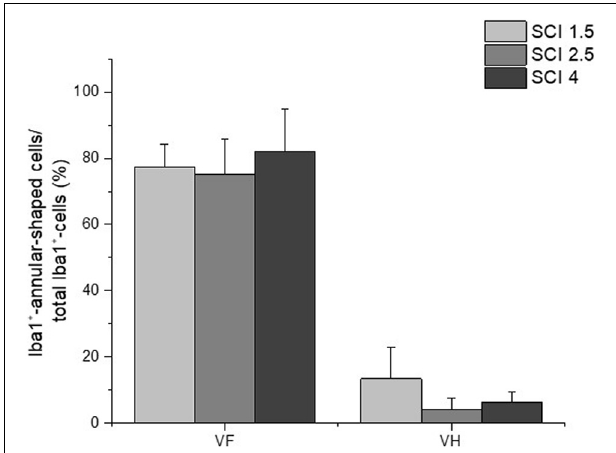
FIGURE 7 | The percentage ratio of Iba1 + -annular-shaped microglia in SCI. The percentage ratio of Iba1 + -annular-shaped cells to the total number of Iba1 + -cells (Y-axis) in the ventral funiculi (VF) and ventral horn (VH) at 60 days after spinal cord injury of mild (SCI 1.5, a light gray column), moderate (SCI 2.5, a gray column), and severe (SCI 4, a black column) severities at a distance of 5 mm caudally from the epicenter of injury. No significant differences in the above indicator of morphometric analysis were found between the experimental groups, one-way ANOVA, followed by a Tukey’s post hoc